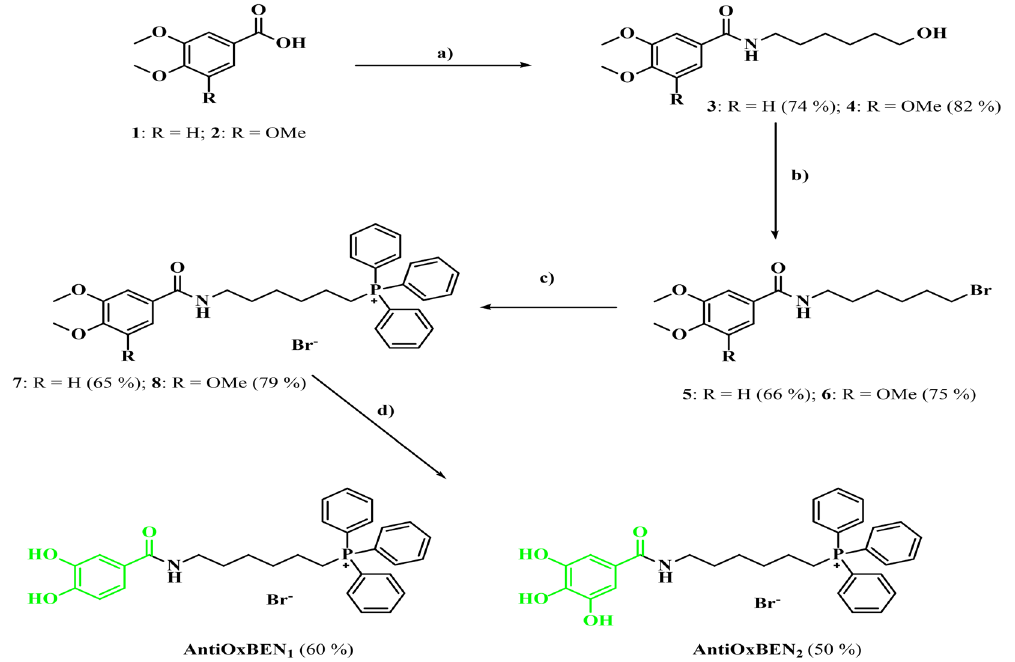
Figure 2. Synthetic strategy used for production of mitochondriotropic antioxidants based on protocatechuic acid (AntiOxBEN 1 ) and gallic acid (AntiOxBEN 2 ). Reagents and conditions: ( a ) triethylamine, ethyl chloroformate, 6-aminohexan-1-ol, dichloromethane, r.t. (12 h); ( b ) 1,2-dibromotetrachloroethane, 1,2-bis(diphenylphosphine)ethane ( diphos ), tetrahydrofuran, r.t. (24 h); ( c ) Triphenylphosphine, 120 °C (48 h); ( d ) BBr 3 , anhydrous dichloromethane, from − 70 °C (10 min) to r.t. (12